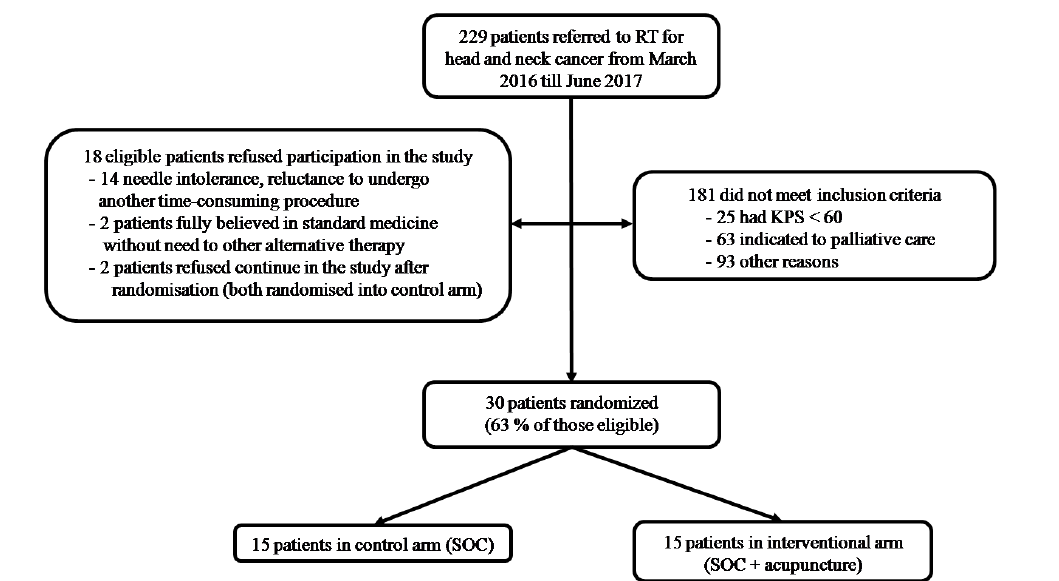
Fig. 1. Flow chart describing patients’ enrollment into the study.